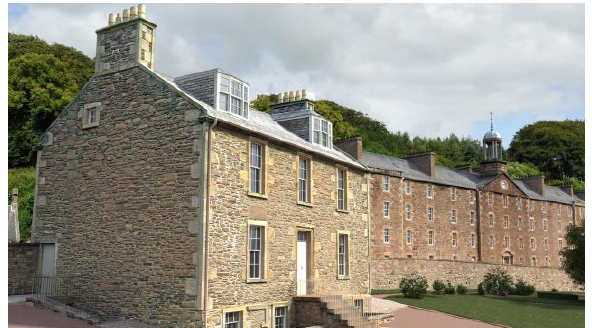
Figure 3. Photo-realistic model of Robert Owen’s House at New Lanark © CDDV 2010.